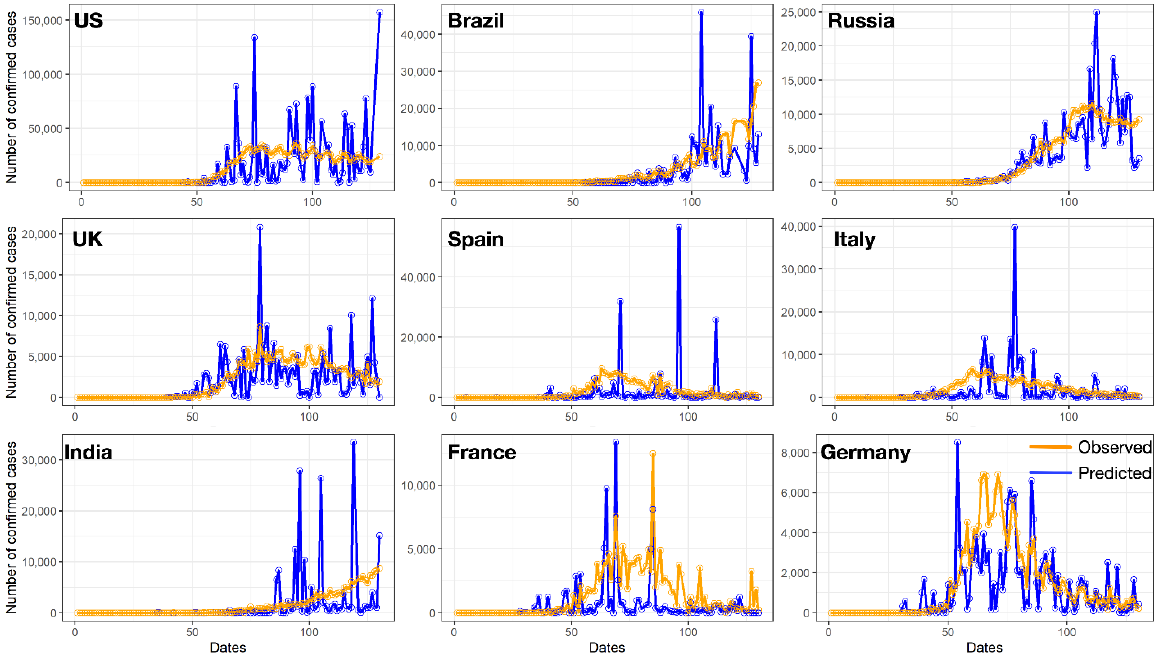
Figure 6. Observed and predicted number of confirmed cases in different